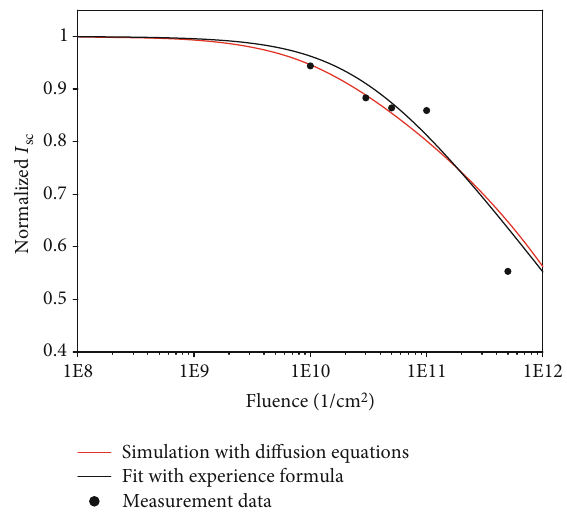
Figure 7: The normalized I vs. 150keV proton fl uence. The red SC curve is the result of calculation, and the black curve is the fi tting result of experimental